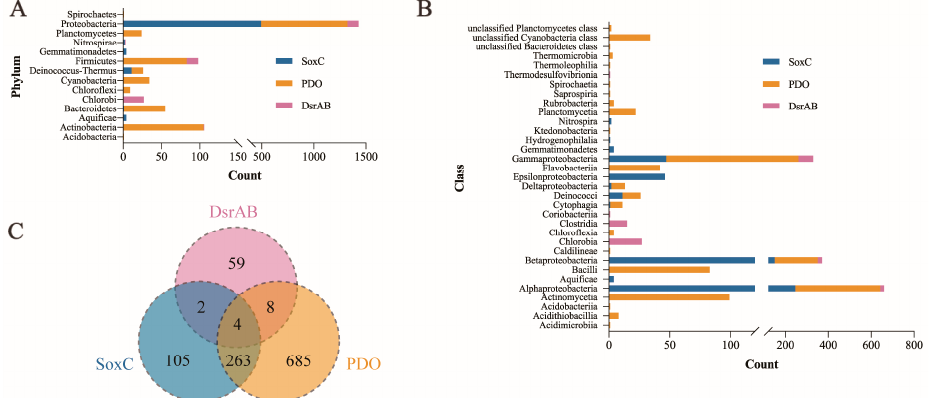
Figure 5. Distribution of homologous proteins of SoxC, PDO and DsrAB in selected bacteria. These homologous proteins were identified through BLASTp in a local database using the amino acid sequences of SoxC, PDO, and DsrAB as queries and further filtered by conserved domain analysis. The distribution of homologous proteins of SoxC, PDO, and DsrAB are shown at the phylum ( A ) and class levels ( B ). ( C ) The Venn diagram showing the number of species which harbored SoxC, PDO or DsrAB in selected bacteria.